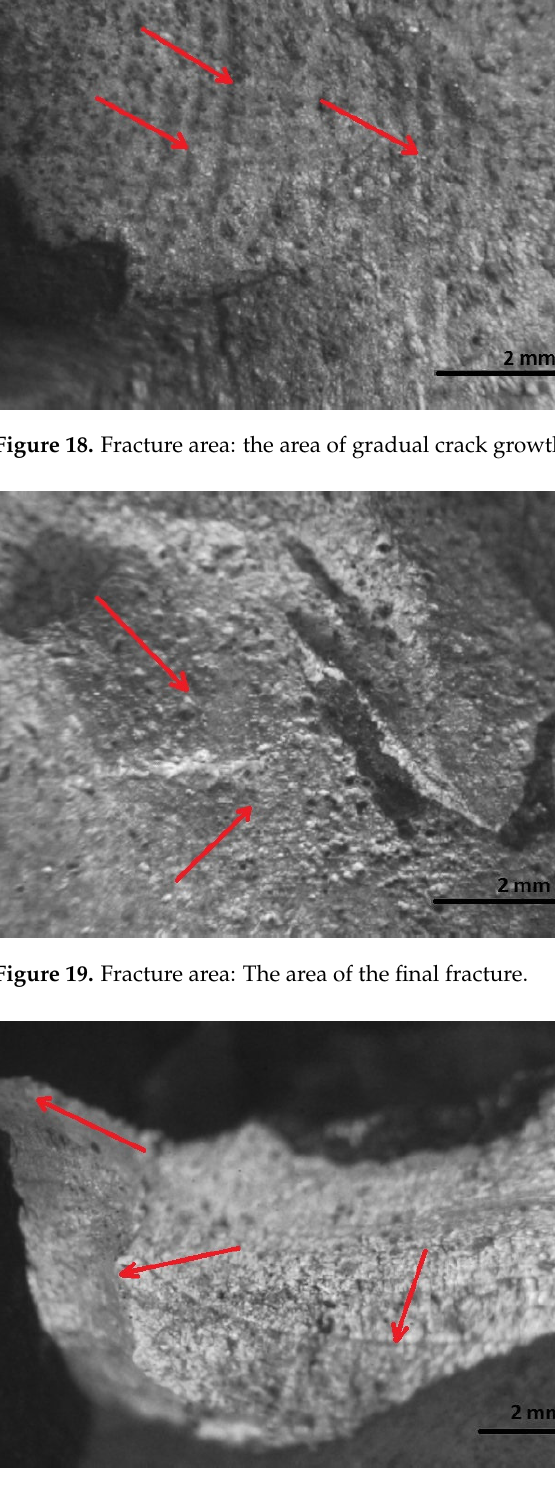
Figure 20. Fracture area: area of plastic deformation.